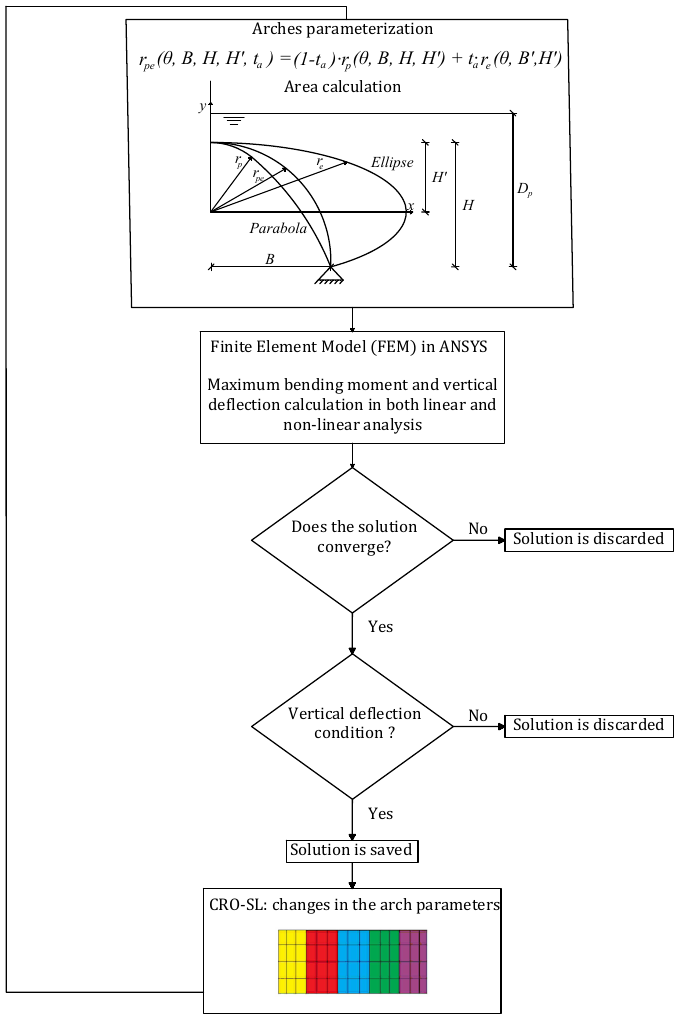
Figure 3. Flow diagram for the functional calculation